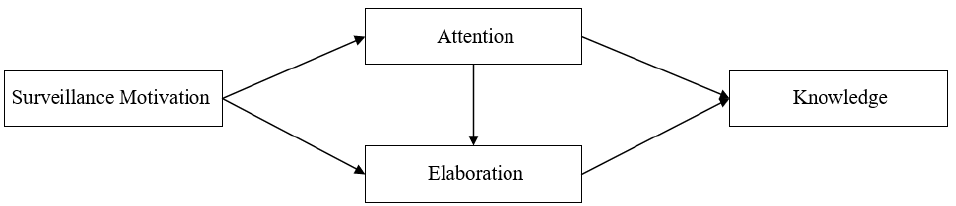
Figure 1. Cognitive Mediation